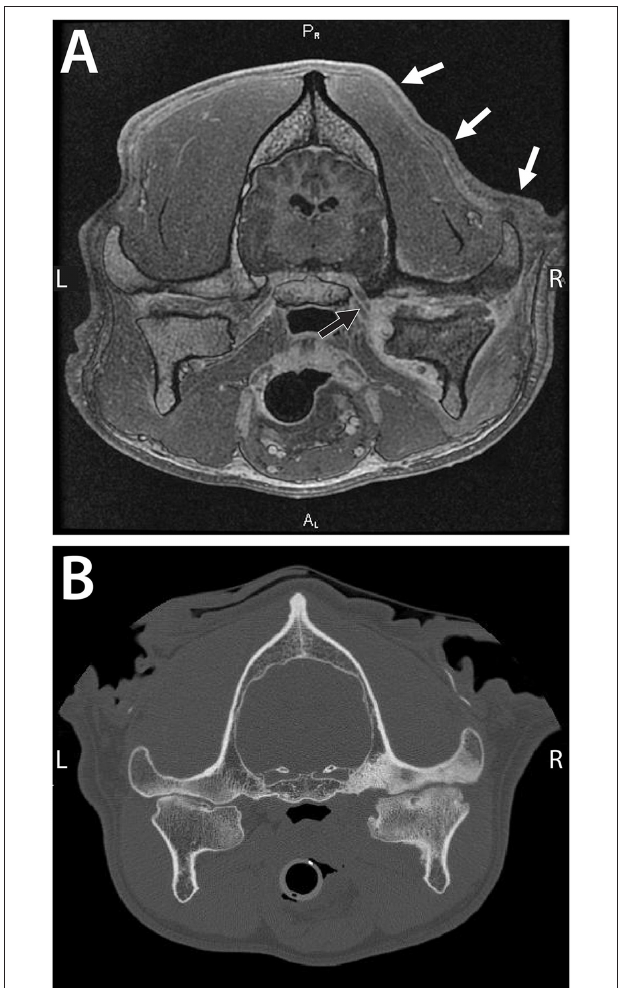
FIGURE 3 | A 7-year-old dog with severe and chronic septic arthritis of the right TMJ described in Case 2. (A) Images from MRI demonstrating severe erosive septic arthritis of the right TMJ with concurrent osteomyelitis including involvement of the mandibular branch of the cranial nerve V (black arrow) and associated neuritis. Note the secondary right-sided atrophy of the masticatory muscles and the temporal muscles, in particular (white arrows). (B) A conventional CT image demonstrating severe bone sclerosis of the condylar process, mandibular head, and mandibular fossa as well as irregular joint space. In addition, lateral and medial osteophytes were noted as well as a periosteal reaction at the medial aspect of the condylar process and subchondral bone cyst at the mandibular head. Note that the contralateral TMJ exhibits features consistent with advanced degenerative changes (Cissell et al., Diagnostic imaging in oral and maxillofacial surgery. In: Verstraete FJM, Lommer MJ, Arzi B, Editors. Oraland Maxillofacial Surgery in Dogs and